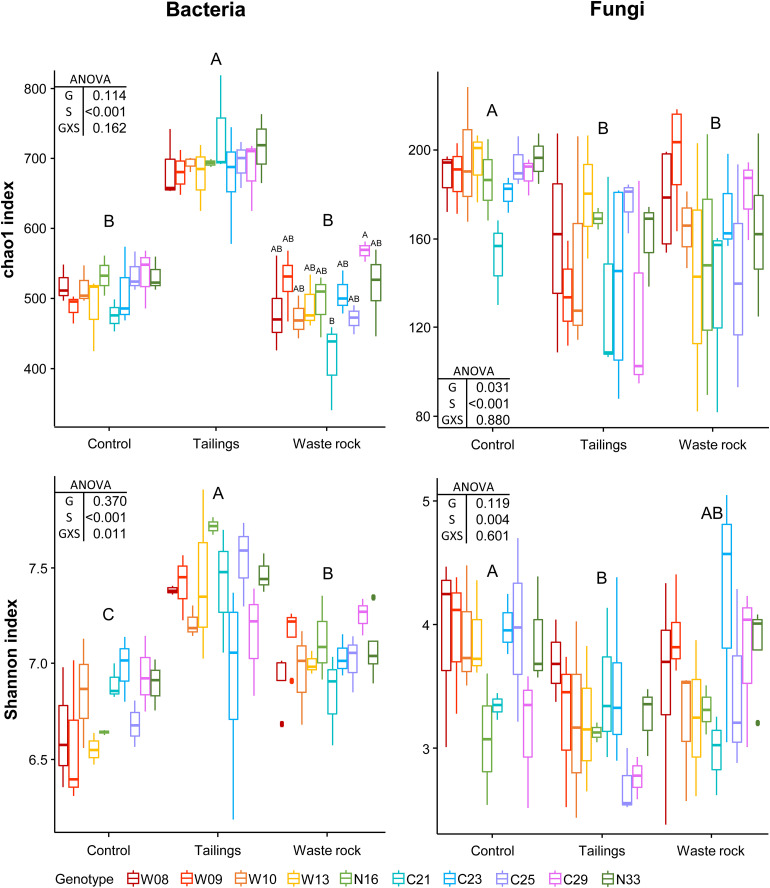
Alpha diversity indices of bacterial and fungal community profiles in greenhouse samples. A two-way ANOVA was used to discern how genotype, substrate type and their interaction influenced alpha diversity indices. In the ANOVA table, G is genotype; S is substrate type; and GXS is the interaction between genotype and substrate type. Shared letters between treatments means there is no significant difference between these treatments, as determined by Tukey HSD post hoc pairwise comparison test (n ≥ 3). Significance level is p < 0.05. Genotype had a significant effect on bacterial richness in waste rock only (chao1 index; p = 0.040).